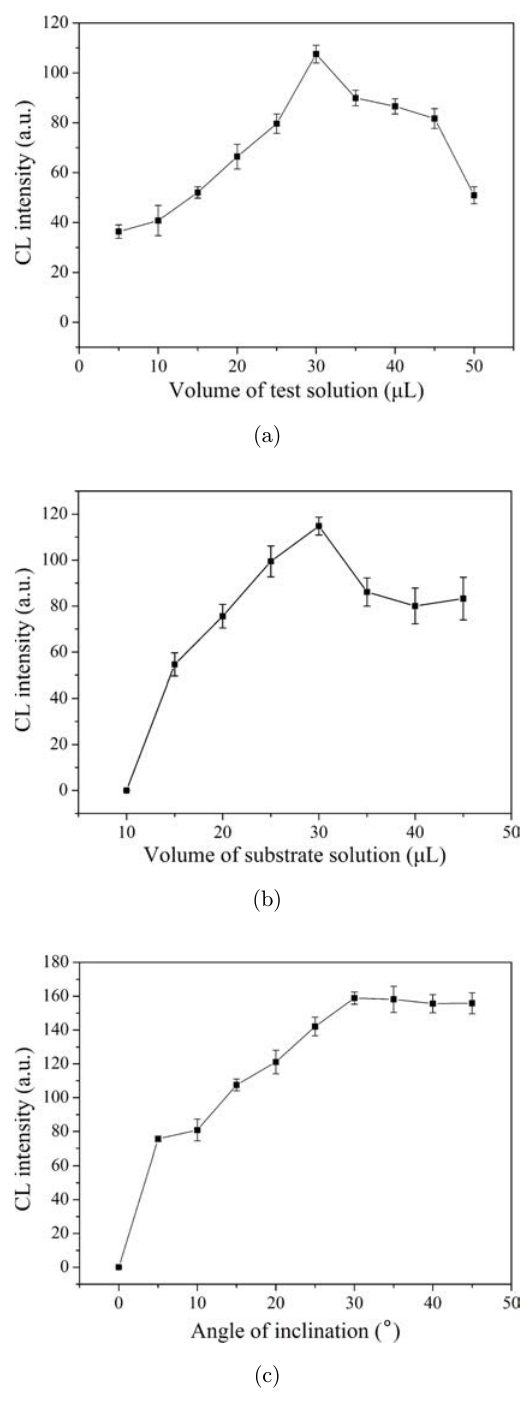
Fig. 4. Luminescence emissions of paper-based GCF-CL in the case of di®erent volumes of test solution (a), volumes of substrate solution (b) and inclination angles (c). In panels (a) and (b), Inclination angle =15 (cid:2) ; in panel (c), the volume of substrate solution test solution ¼ 30 (cid:2) L/30 (cid:2) L. Assay condi- tions: [Cr(III)] ¼ 50 mg/L; [luminol] ¼ 1.5 mM; [H 2 O 2 ] ¼ 0.2 M; [KBr] ¼ 0.75 M; [EDTA] ¼ 1 mM; pH of test/substrate solu- tions ¼ 3.00/11.50. The error bar is the standard error from eight independent